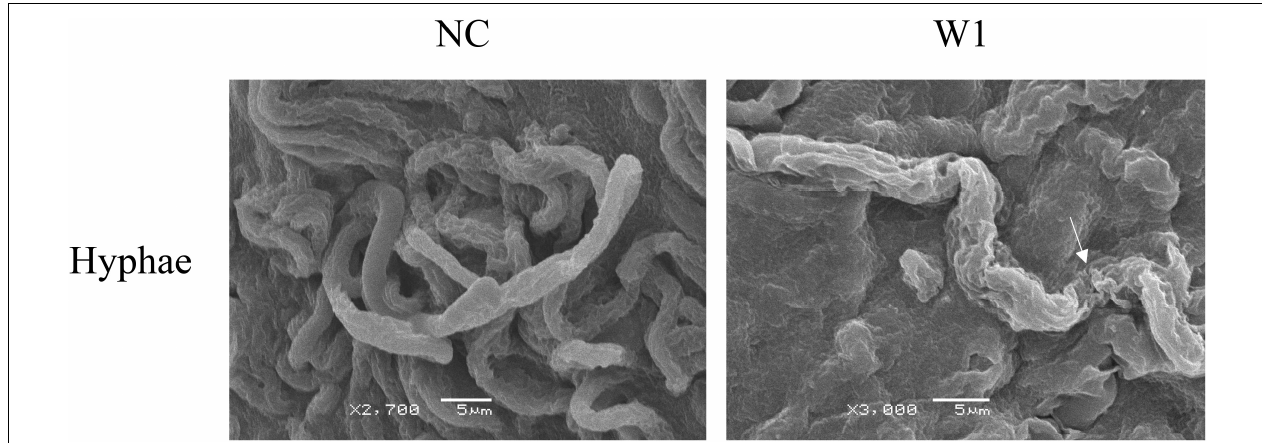
FIGURE 6 | Scanning electron microscopy observation of hyphae of F. oxysporum treated with W1. The mycelium of F. oxysporum was treated with the purified W1 (160 µ g/ml) at 30 ◦ C for 24 h, while treated with PBS as control. Images was observed and captured using a JSM-6380LV SEM (JEOL Instruments Inc., Japan) at 15 kV. The white arrows represent the morphological deformation in hyphae when treated with